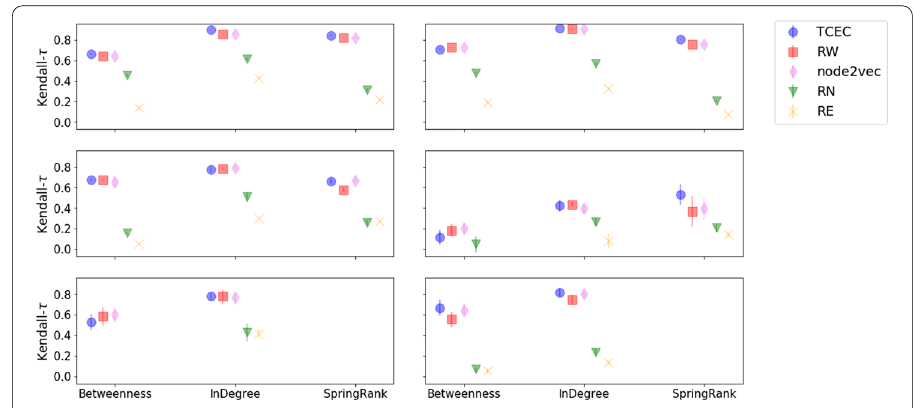
Fig. 2 Approximation of non-spectral centrality measures with various sampling algorithms for the real datasets Epinions(upper left), Slashdot(upper right), Stanford(center left), Adolescent Health(center right), C. Elegans(bottom left) and US Power grid(bottom right). Scatterplots represent average results over 10 runs of sampling, with standard deviation indicated by vertical bars. SpringRank is missing for undirected